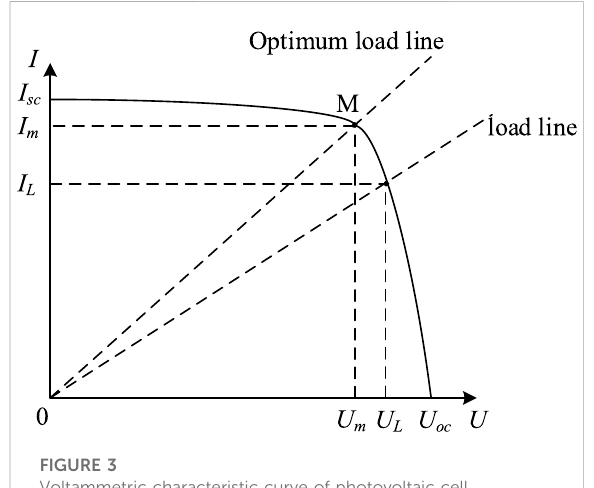
FIGURE 3 Voltammetric characteristic curve of photovoltaic cell.